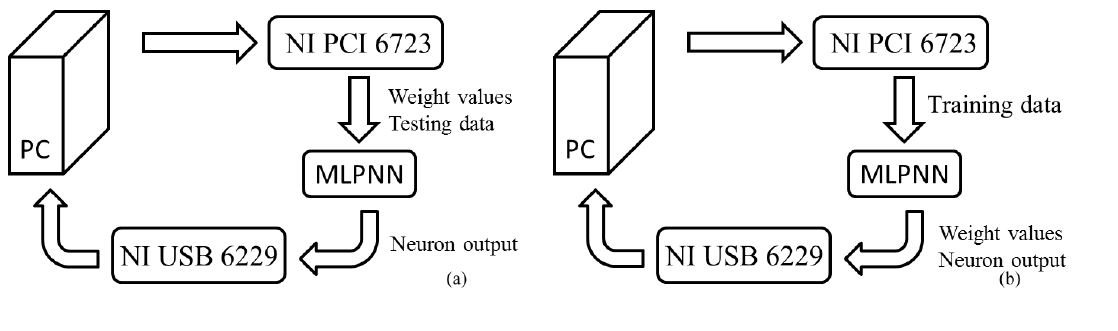
Figure 12. The block diagram for training and testing: ( a ) training and ( b )